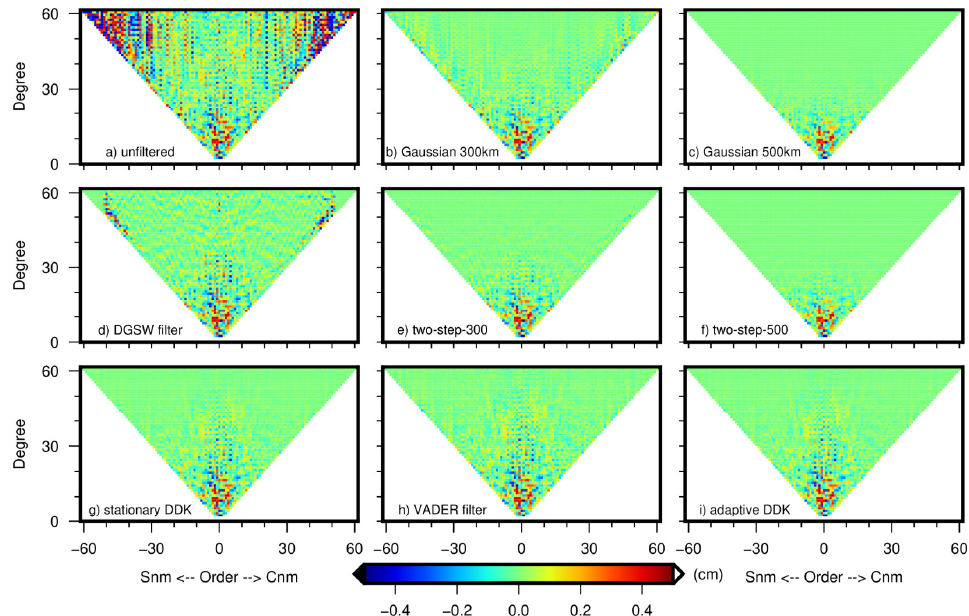
Figure 9. The unfiltered and filtered solutions in the SH domain for July 2010.